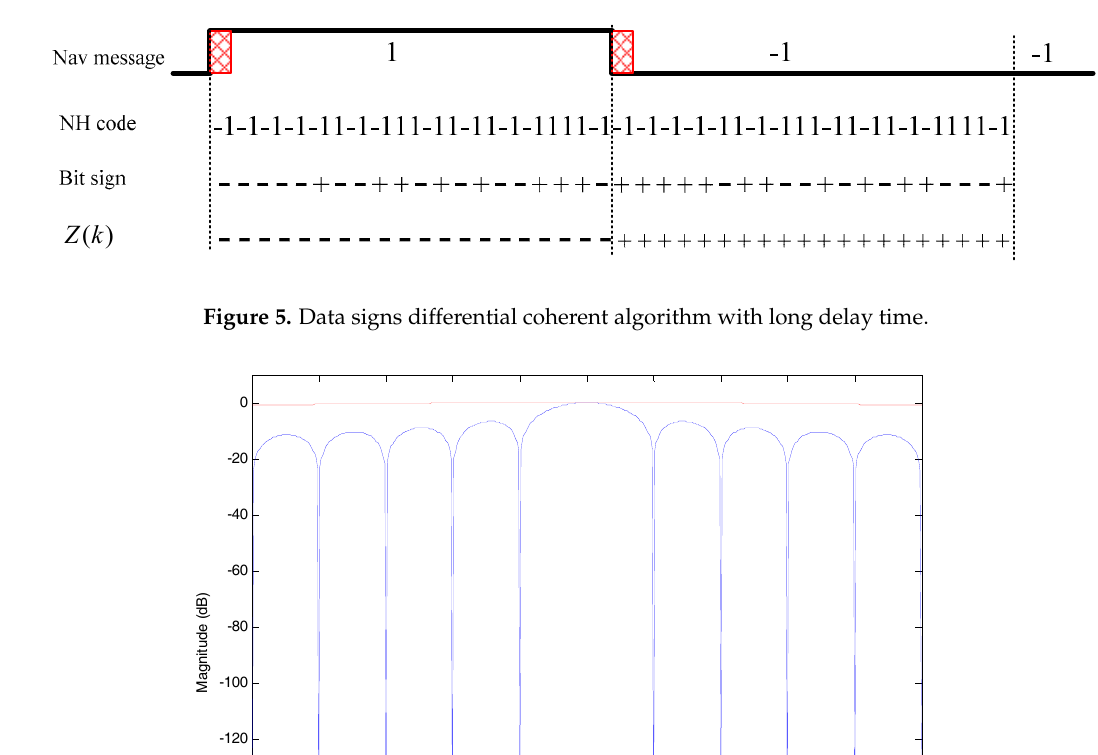
8 of 18 Figure 4. The amplitude attenuation of differential coherent algorithm due to frequency deviation.